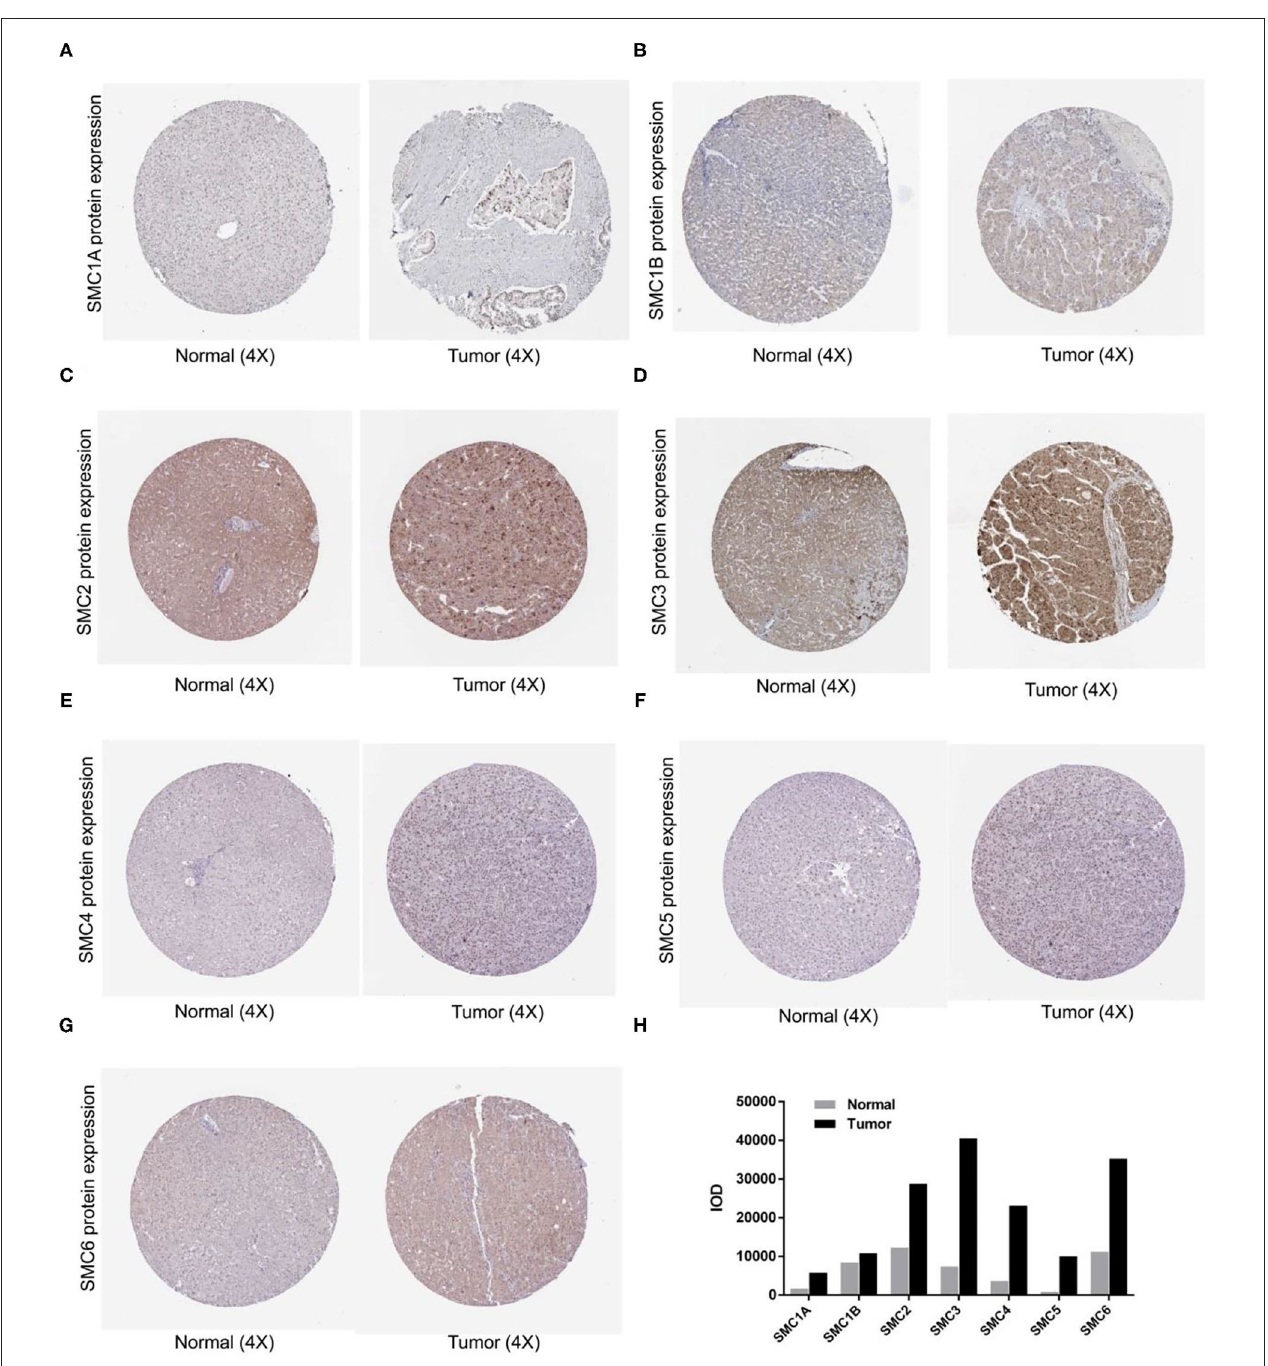
FIGURE 2 | Protein expression levels of SMC family members in HCC. (A-G) The HPA database shows the protein expression levels of SMC1A , SMC1B , SMC2 , SMC3 , SMC4 , SMC5 , and SMC6 in HCC tissues compared with non-cancerous tissues. (H) The integrated optical density (IOD) was used to analyze the expression difference between HCC tissues and noncancerous